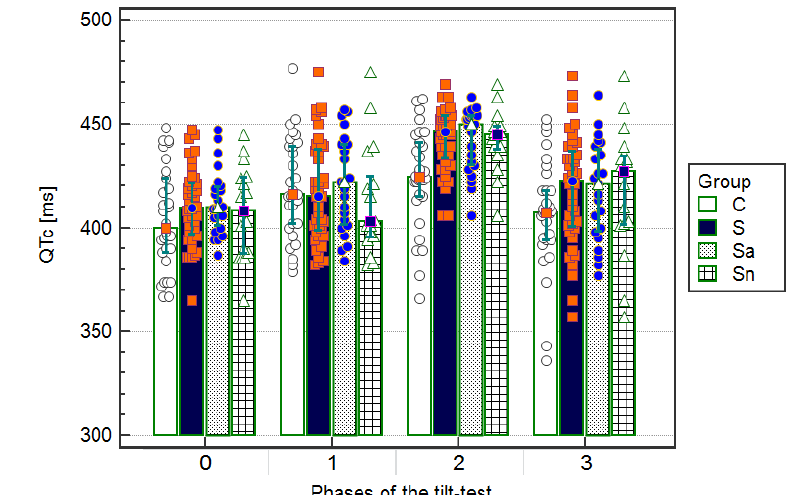
Figure 3. Values of QTc intervals in electrocardiograms (ECGs) on admission to the hospital (Phase 0) and during the resting supine (Phase 1), the upright phase (Phase 2), and the returning to supine phase normal T. Values [ms] are shown as a median and interquartile range. A significant di ff erence ( p < 0.05)